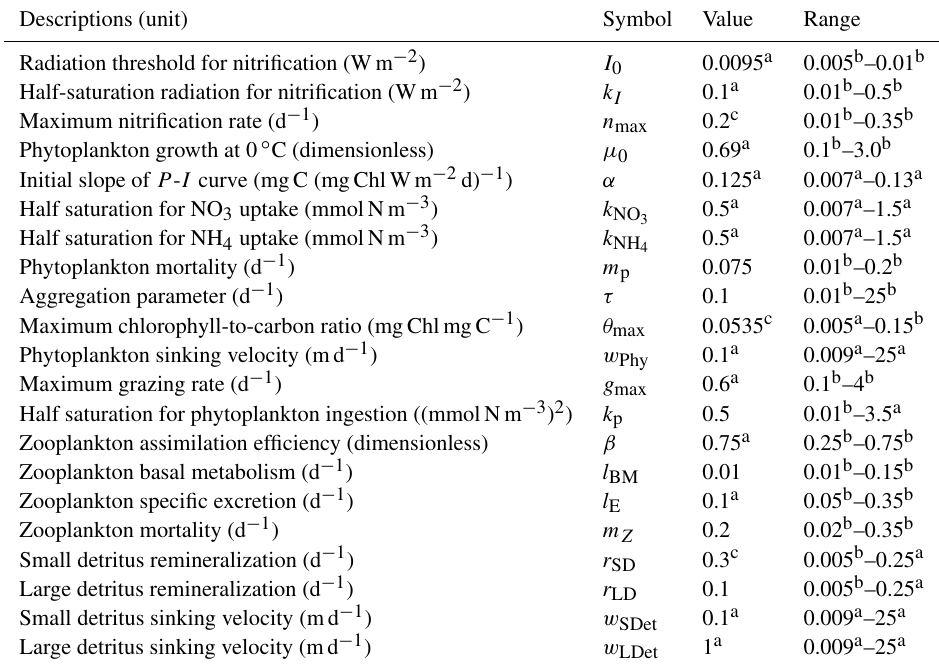
Table 1. Initial values and ranges of biogeochemical model parameters. Descriptions